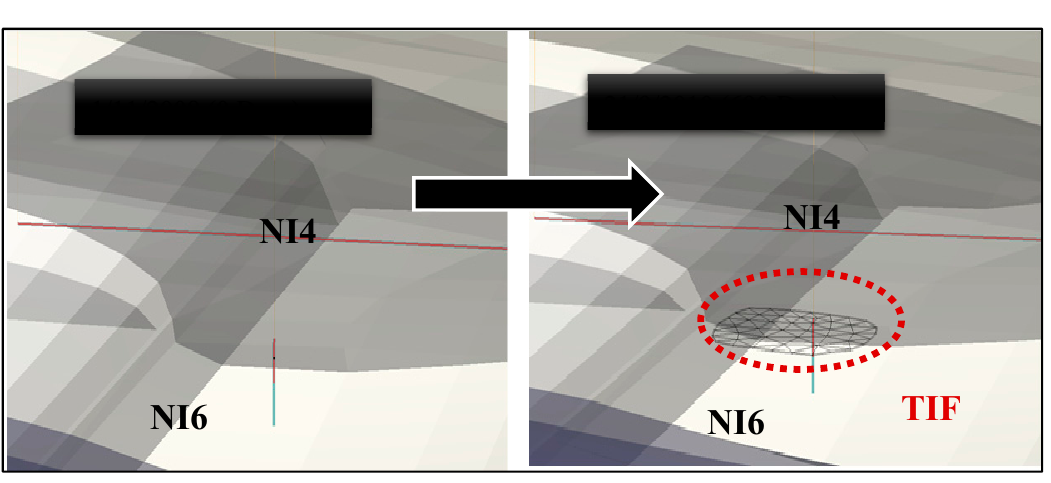
Figure 41. Geometry of the TIF around Well NI6 after 690 days.